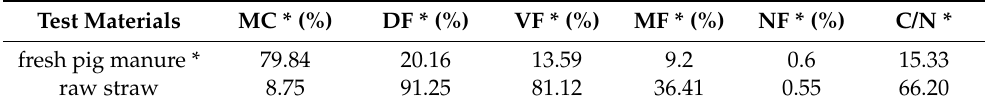
Table 1. Nature of raw